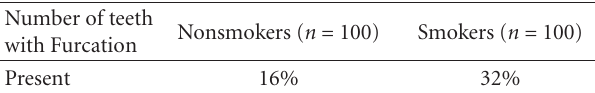
Table 4: Comparison of probing depth between nonsmokers and smokers. Results are presented in trimean (min-max).